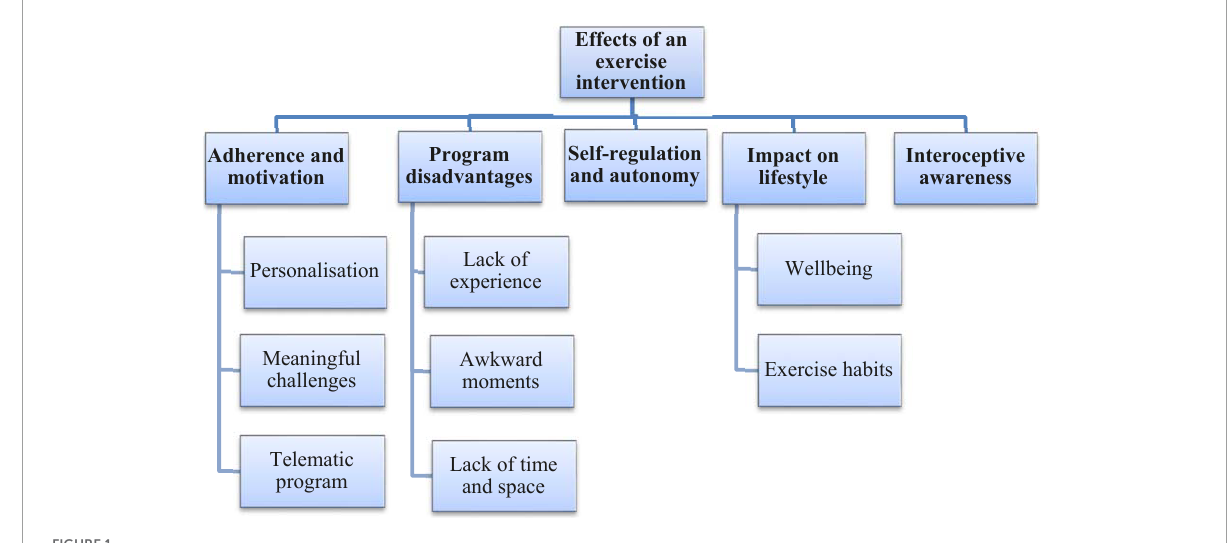
FIGURE1 Themes and subthemes developed from the experiences of people participating in the exercise programs.